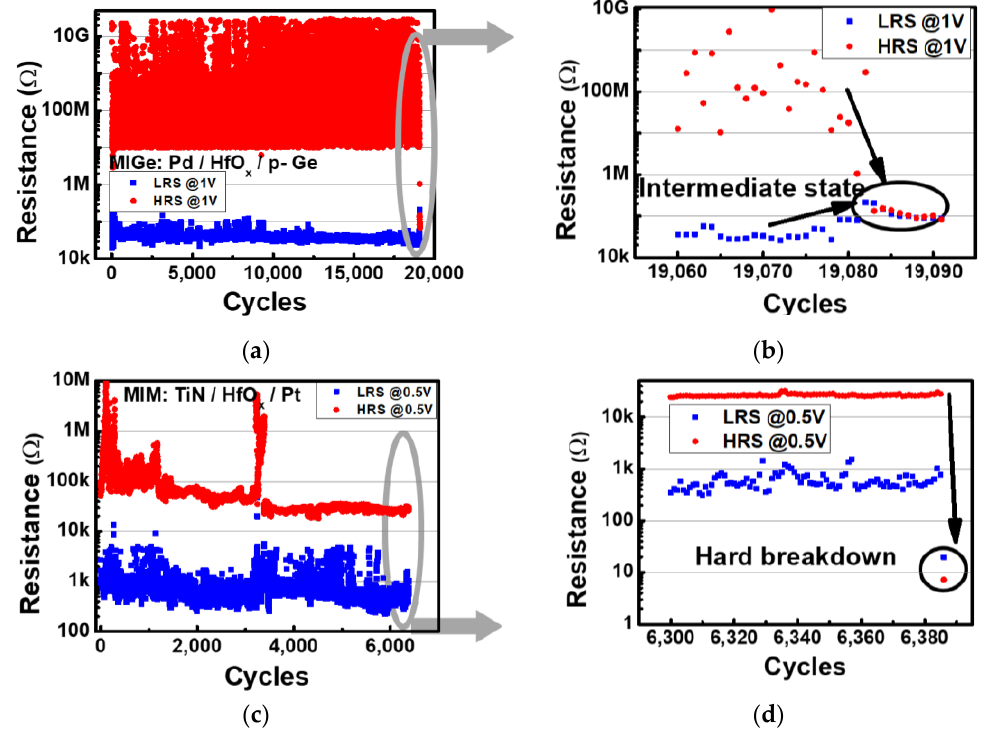
Figure 6. DC endurance cycles of ( a ) Pd/HfO x /p-Ge devices (10 MΩ for minimum of HRS and 500 kΩ for maximum of LRS in test code) and ( c ) TiN/HfO x /Pt devices (50 kΩ for minimum of HRS and 5 kΩ for maximum of LRS in test code); DC endurance failure of ( b ) Pd/HfO x /p-Ge devices and ( d ) TiN/HfO x /Pt devices.